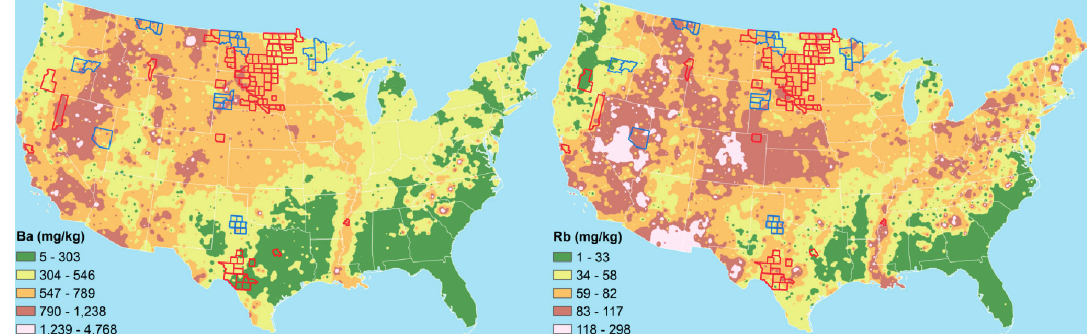
Figure 3. Barium and rubidium soil concentration gradient maps for the contiguous United States. Red counties = cases and/or outbreaks of agricultural/wildlife anthrax since 2000. Blue counties = no reported cases and utilized for geochemical statistical comparisons with red